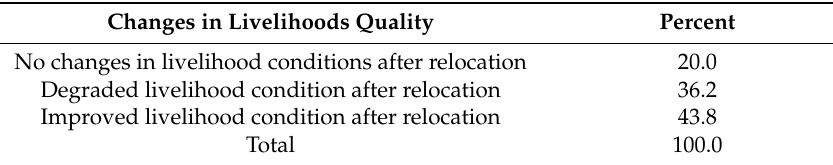
Table 9. Livelihoods after